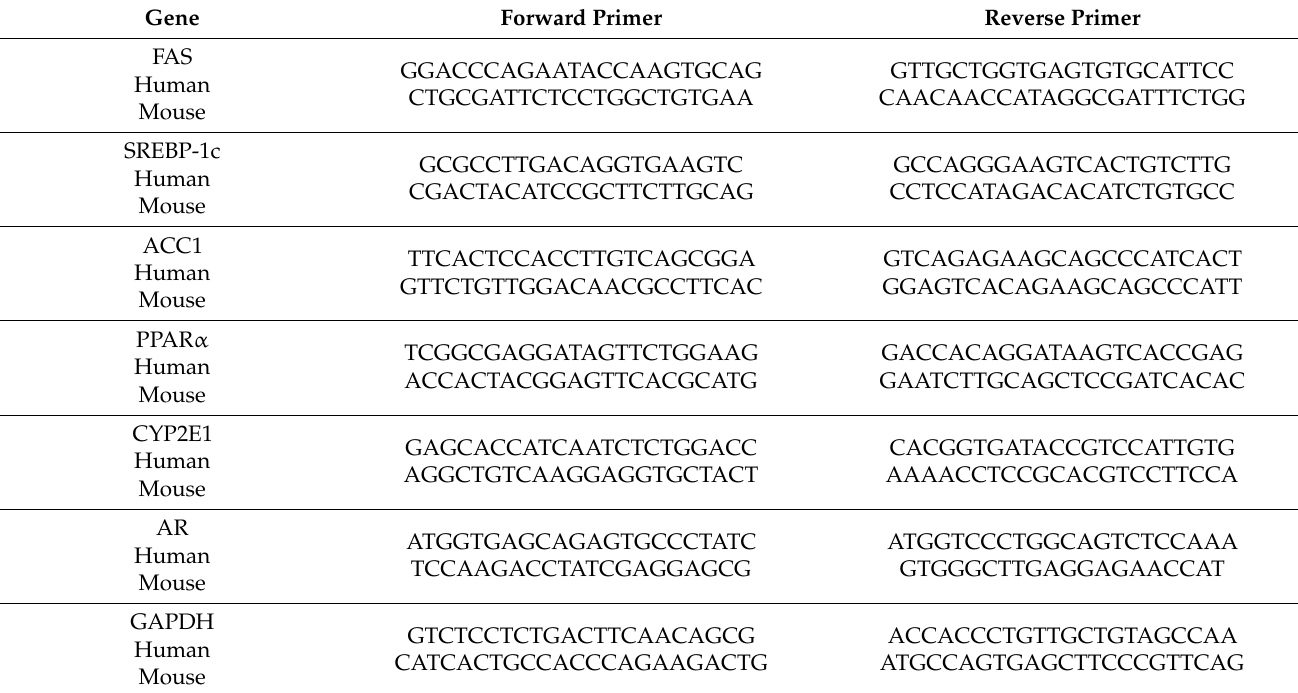
Table 1. Primes for RT-qPCR